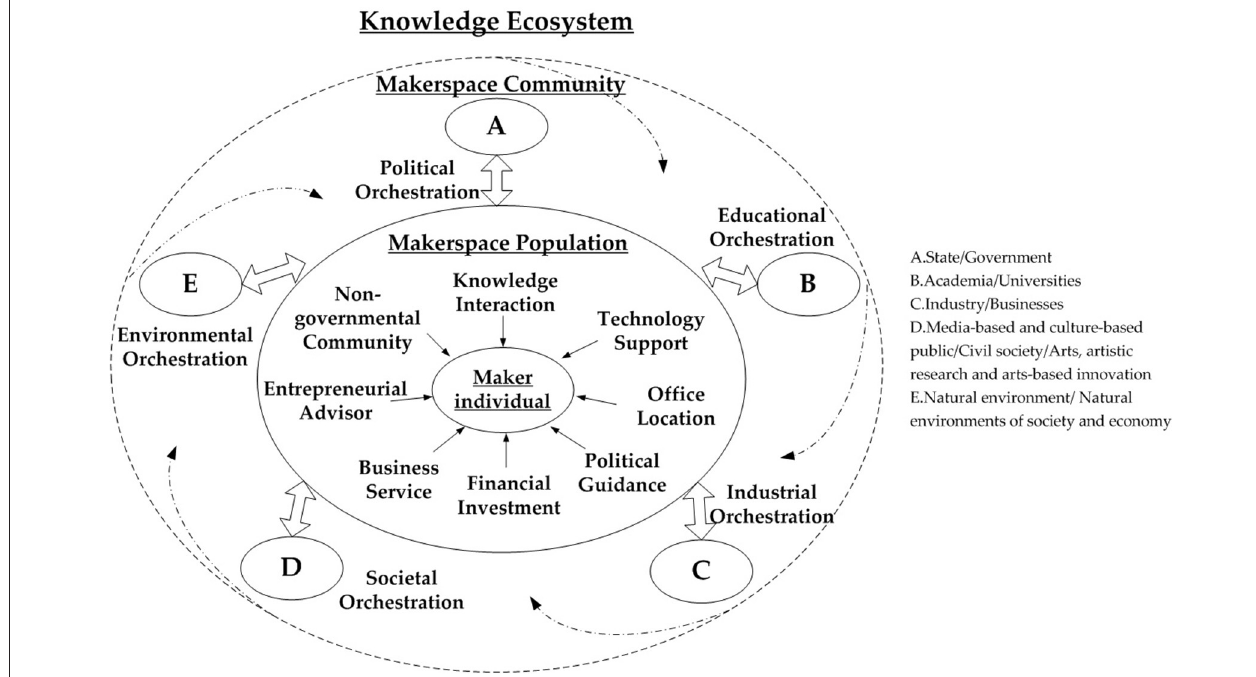
FIGURE 7 | Multi-level framework of knowledge ecosystem (top view).